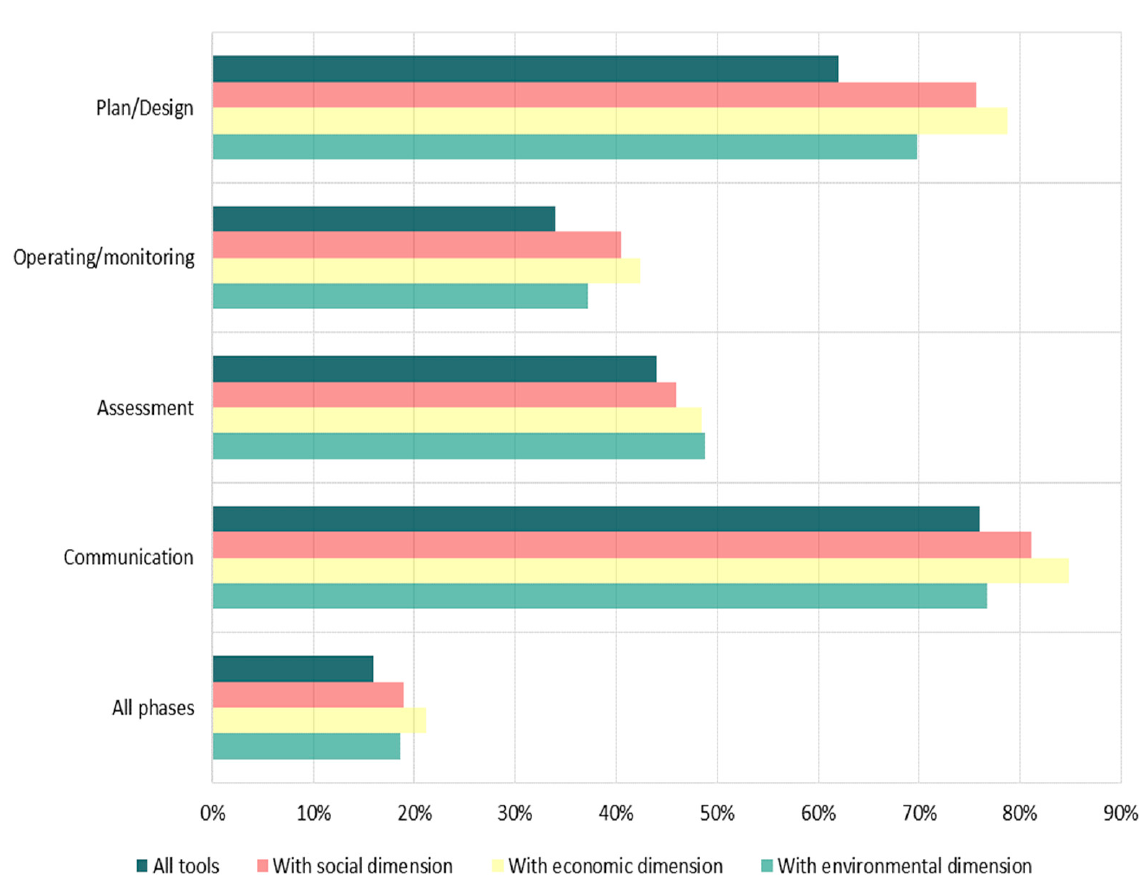
Figure 4. Phases of edible NBS implementation addressed by the tools.